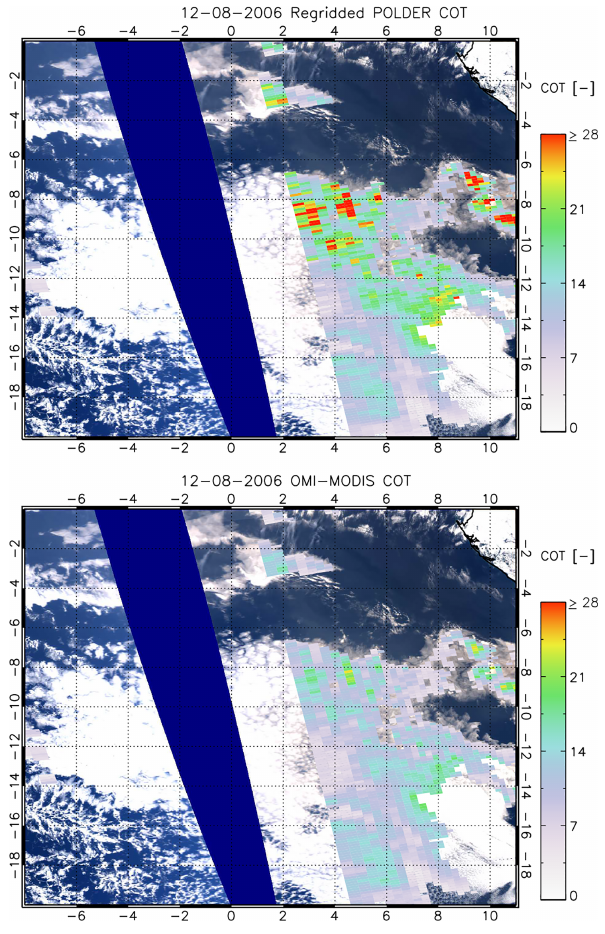
Figure 6. Cloud optical thickness (COT) overplotted on a MODIS RGB image on 12 August 2006 for POLDER at 0.87µm regrid- ded to OMI grid (upper panel) and OMI–MODIS at 1.2µm (lower panel).